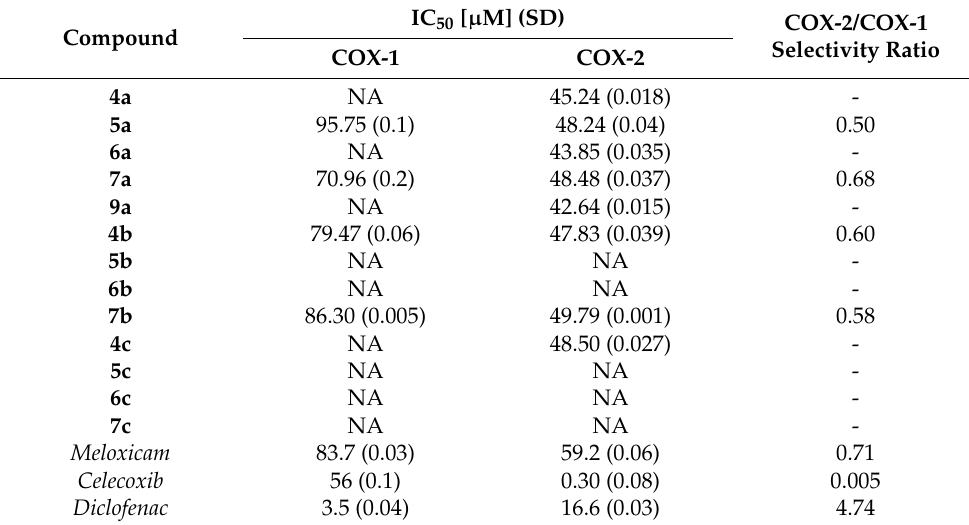
Table 2. The IC 50 [ µ M] values determined for COX-1 and COX-2.